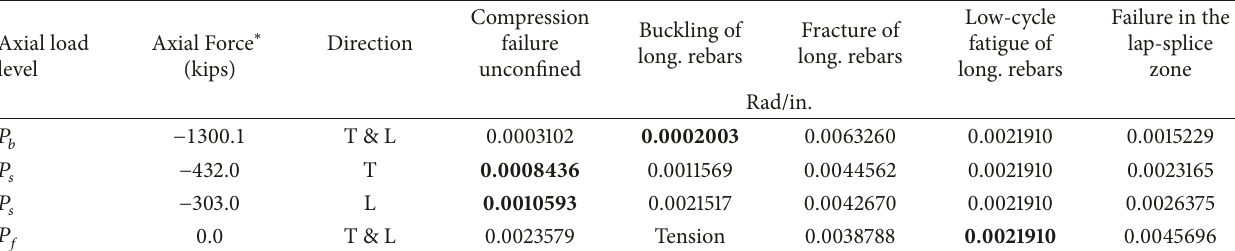
Table 12: Plastic curvature capacity of Pier #2 columns, Bridge #3-E.